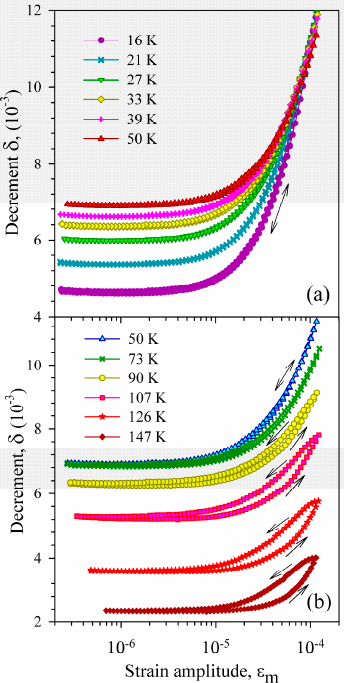
Figure 5. Strain amplitude dependence of the decrement of a Ni 50.8 Ti 49.2 sample, subjected to vacuum quenching (VQ), measured at different temperatures during heating from 16 K.